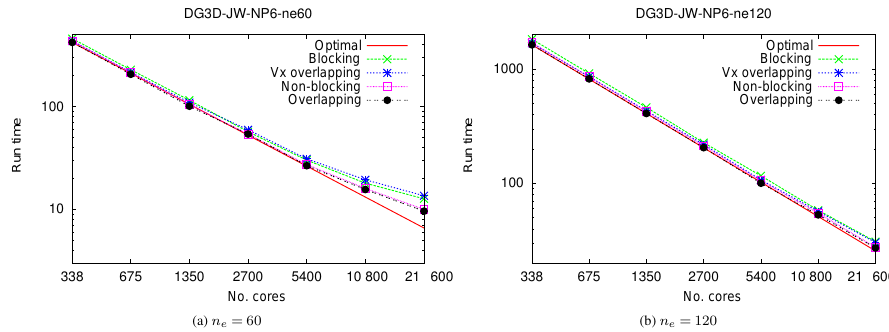
Figure 6. Strong scaling of the HOMME-DG code for the Jablonowski–Williamson baroclinic wave instability test case. For the run we used np = 6, nlev = 26, and (a) n e = 60 or (b) n e = 120. For each run we compute 4500 time